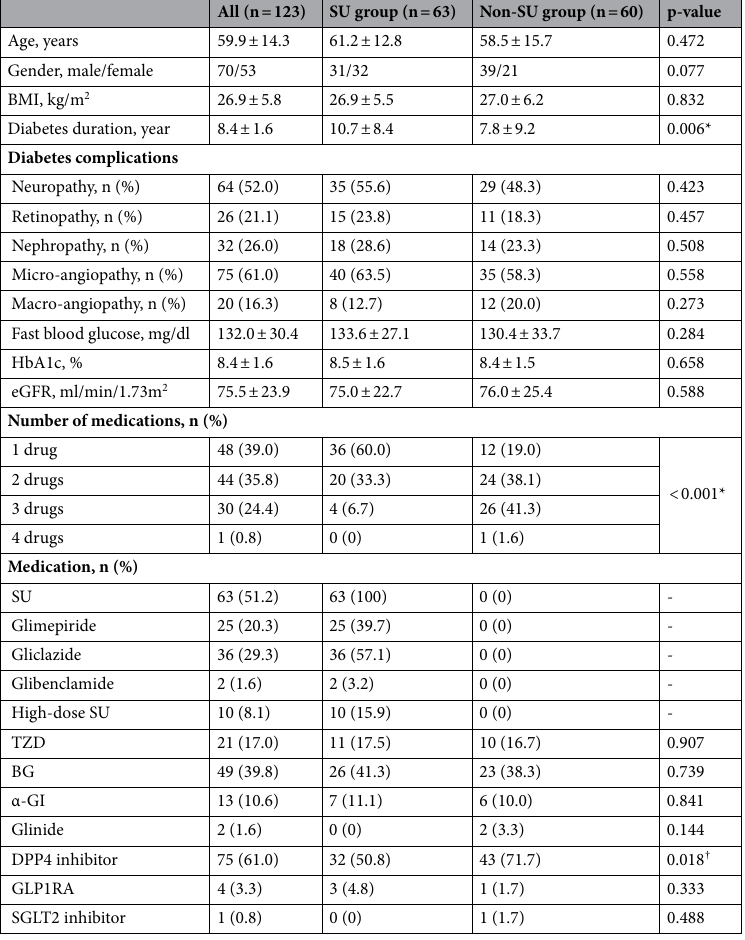
Table 1. Clinical characteristics of study participants. Data are mean ± SD or n (%). P values are for differences between the SU and non-SU groups. *p < 0.05 by Mann–Whitney’s U test. † p < 0.05 by χ 2